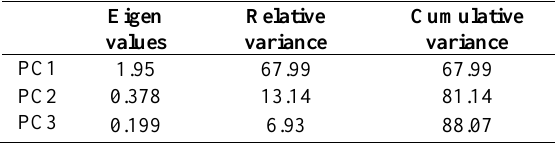
Table 4. Analysis of molecular variance among and within species using SDS-PAGE pattern.